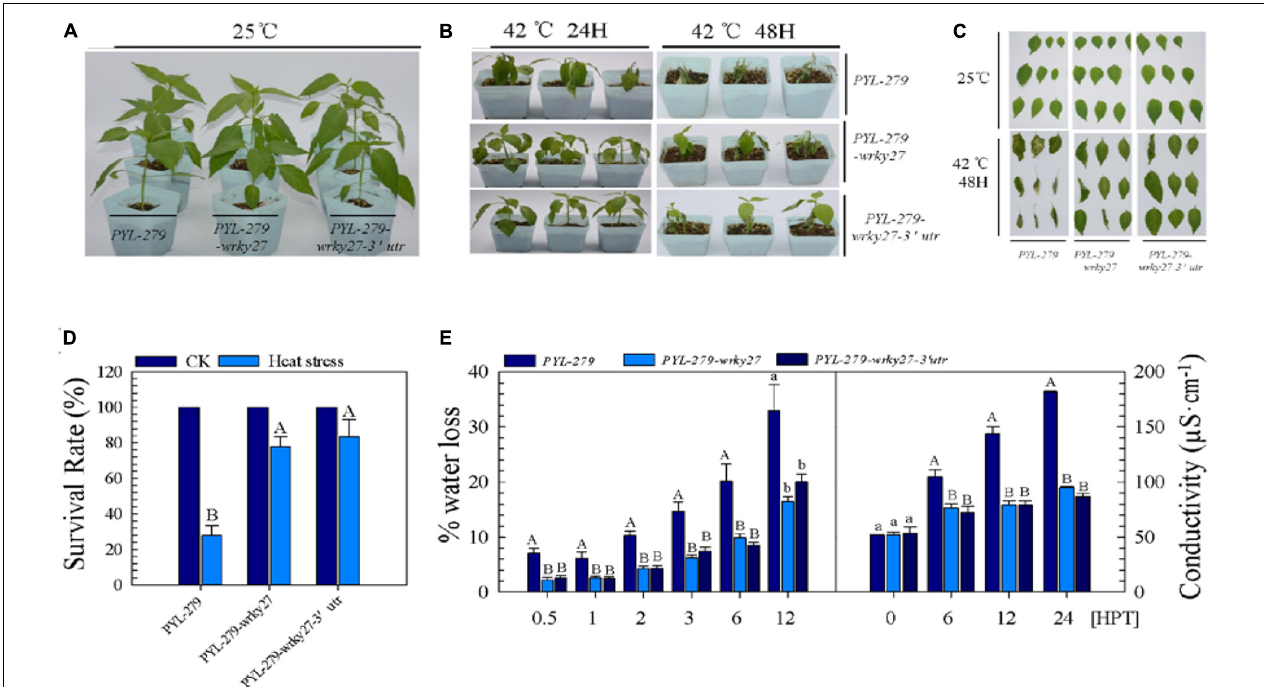
FIGURE 2 | CaWRKY27 silencing enhanced basal thermotolerance in pepper plants. (A) PYL-279 , PYL-279-wrky27 , and PYL-279-wrky27-3 ’ utr pepper plants that were grown in pots for 6 weeks under normal conditions. (B) Phenotypes of PYL-279 , PYL-279-wrky27 , and PYL-279-wrky27-3 ’ utr pepper plants after 3 days recovery following heat treatment at 42 ◦ C for 24 or 48 h. (C) Digital photographs of isolated leaves from the corresponding plants. (D) Survival rate were analyzed in PYL-279 , PYL-279-wrky27 , and PYL-279-wrky27-3 ’ utr plant after 3 days recovery following heat treatment at 42 ◦ C for 48 h. Data represent the mean ± SE ( n = 3), each replicate consists of six plants. (E) Percentage of water loss and ion leakage (conductivity) were detected in PYL-279 , PYL-279-wrky27 , and PYL-279-wrky27-3 ’ utr leaves. Data represent the mean ± SE of three biological replicates. Different letters indicate significant differences compared to PYL-279 plant leaves ( SNK -test, lowercase letters indicate P < 0.05, and uppercase letters indicate P < 0.01).